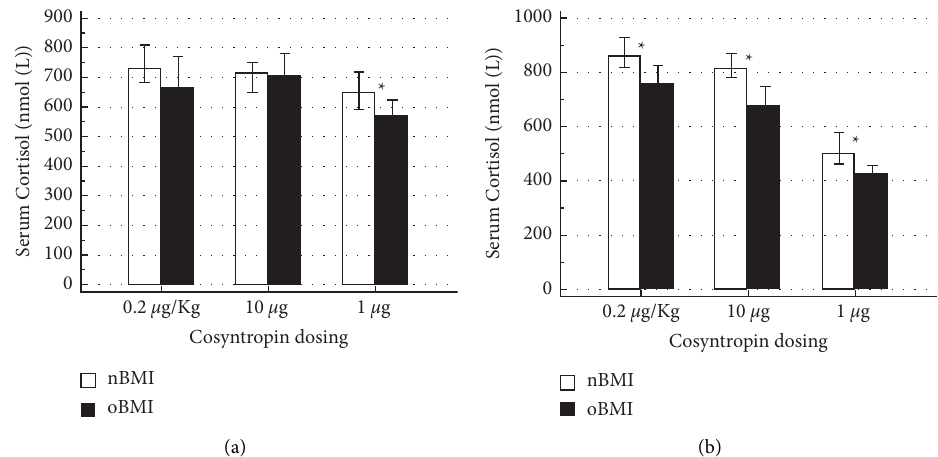
Figure 2 : (a) Serum cortisol response to cosyntropin at +30 minutes (nmol/L). Results are presented as median, interquartile range. Kruskal–Wallis test for independent samples. ∗ p value < 0.05. (b) Serum cortisol response to ACTH at +60 minutes. Results are presented as median, interquartile range. Kruskal–Wallis test for independent samples. ∗ p value <